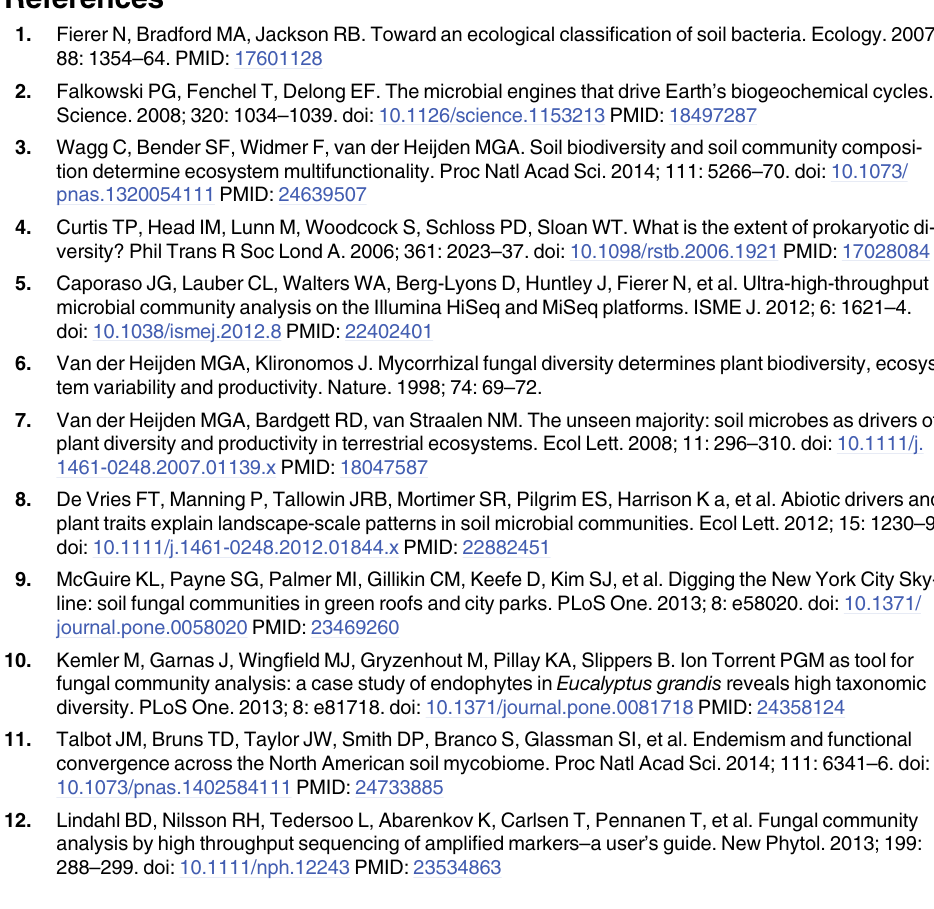
S1 Table. One-way ANOVA of alpha diversity indexes and ADONIS in the three treatments on sequencing sample